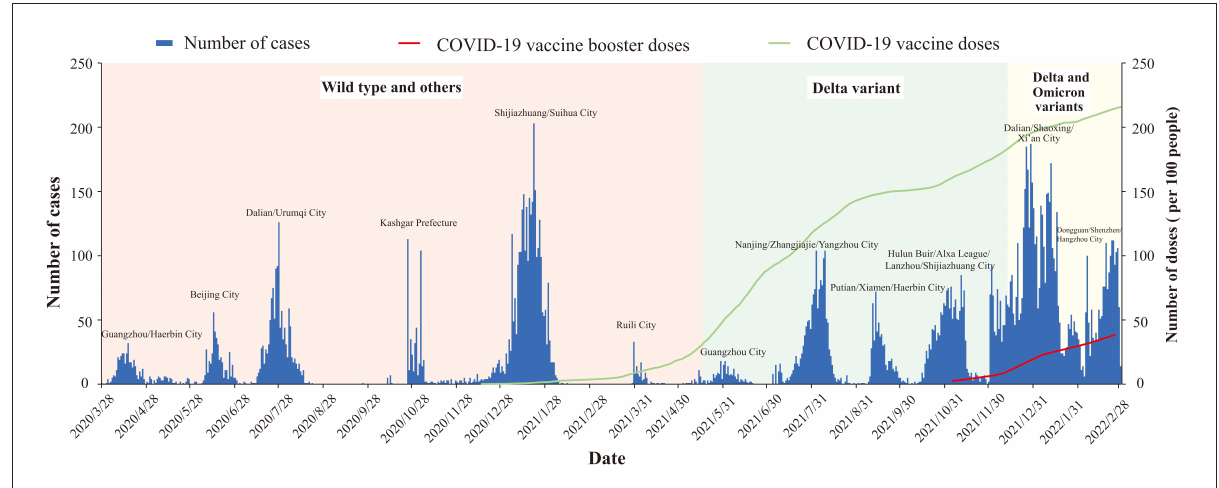
FIGURE2 Epidemic curve COVID-19 transmitted locally in China from March 28, 2020 to March 1, 2022.